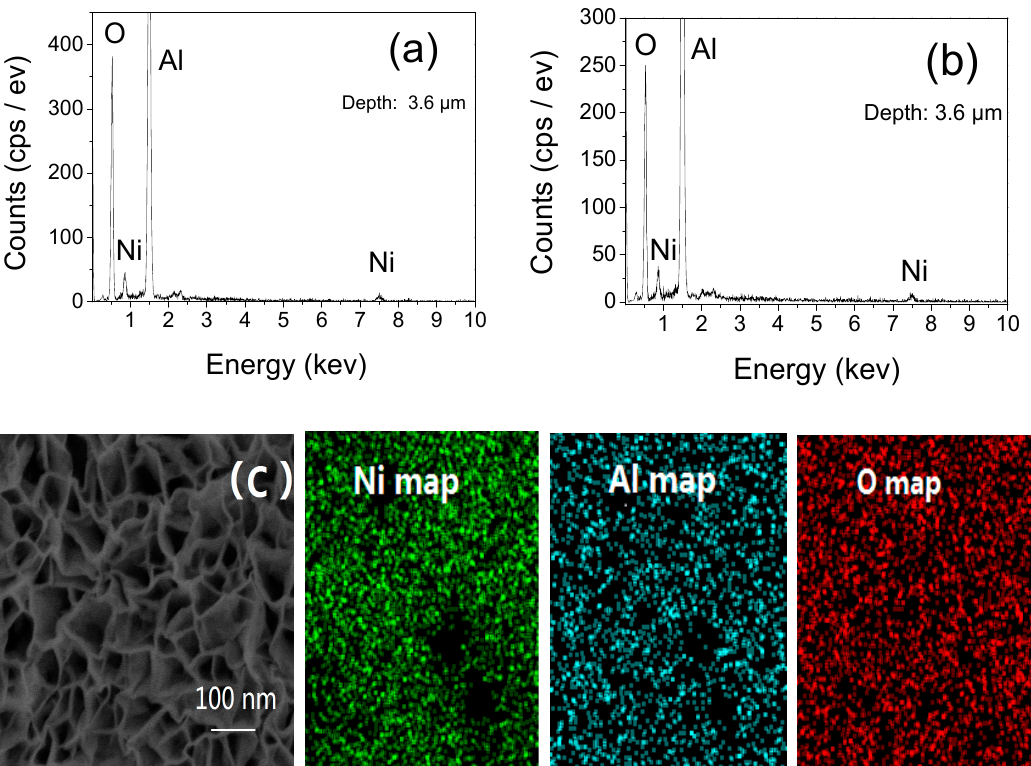
Figure 3. EDS pattern of the as-prepared ( a ) flower-like and ( b ) grain-like Ni / Al 2 O 3 / Ni film and ( c ) enlarged SEM image of the flower-like Ni / Al 2 O 3 / Ni film and the corresponding mapping of Ni, Al, and O. Table 1. EDS pattern of as-prepared flower-like Ni / Al 2 O 3 / Ni film.